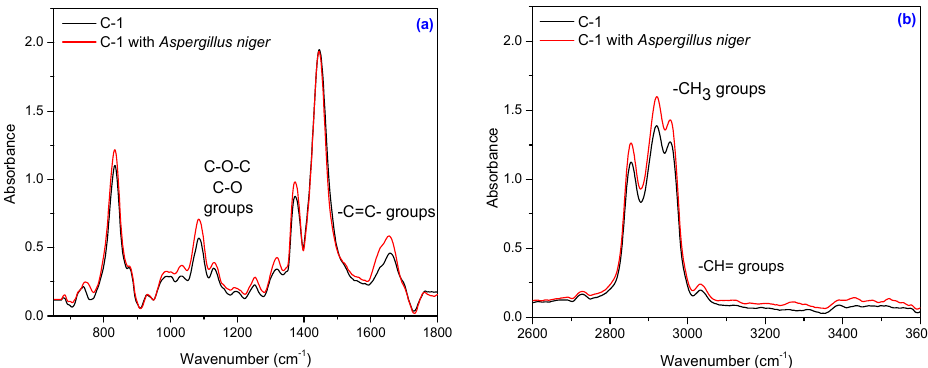
Figure 15. Infrared spectrum of the C-1 sample: ( a ) in the range of 650–1800 cm − 1 and ( b ) in the range of 2600–3600 cm − 1 . Materials 2017 , 10 , 787